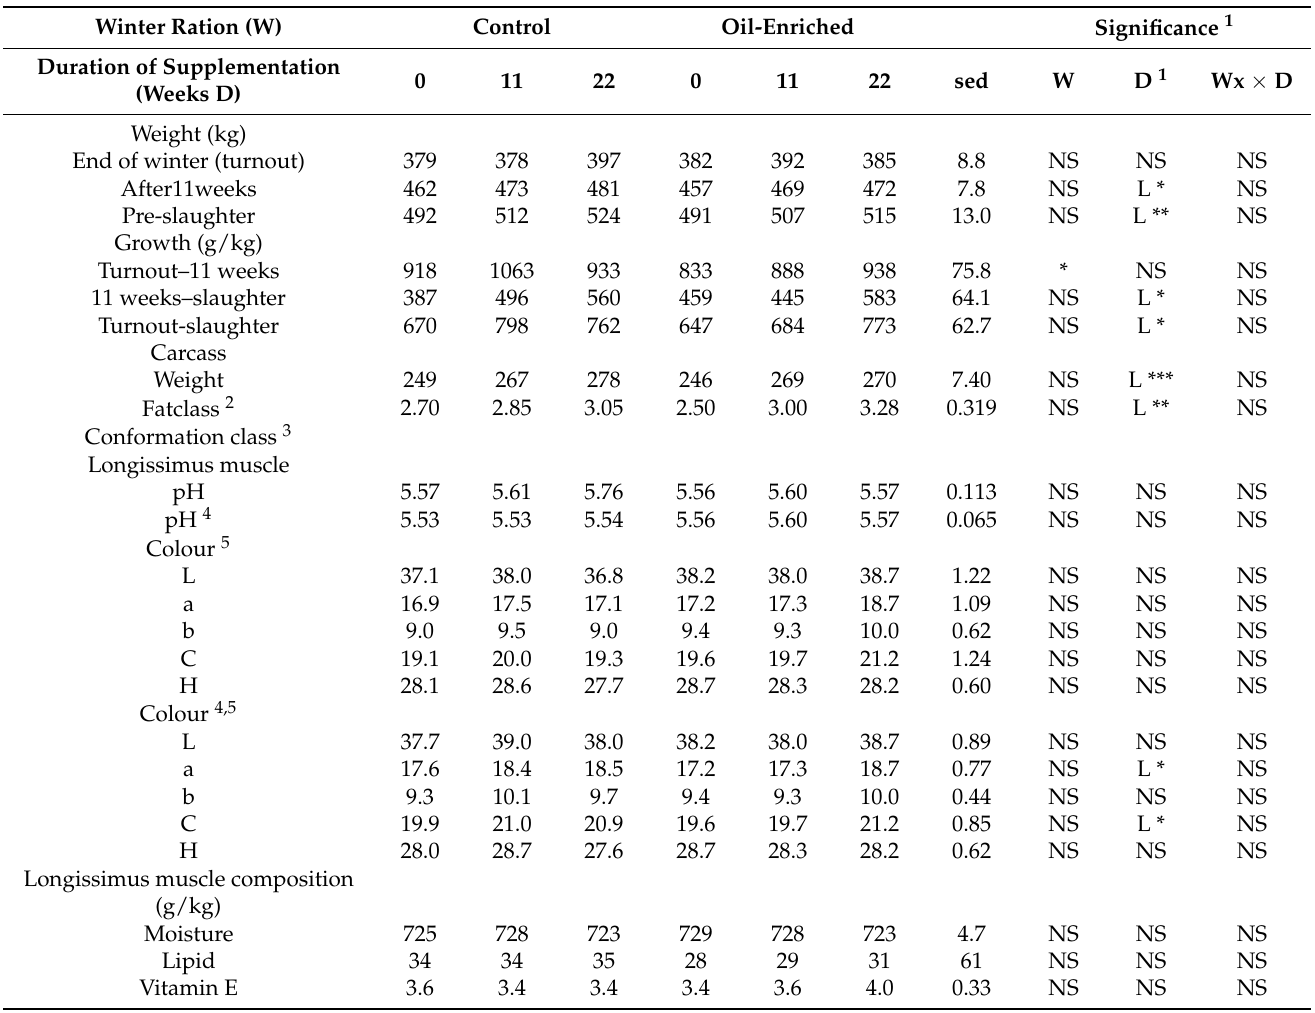
Table 2. Growth, carcass and muscle characteristics of beef